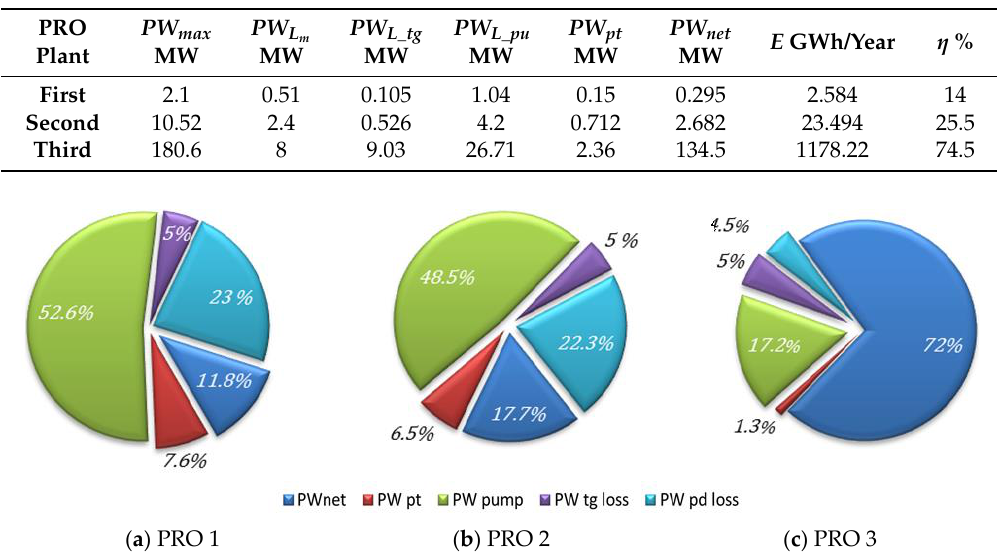
Table 6. PRO power plants power generation capacities and losses.